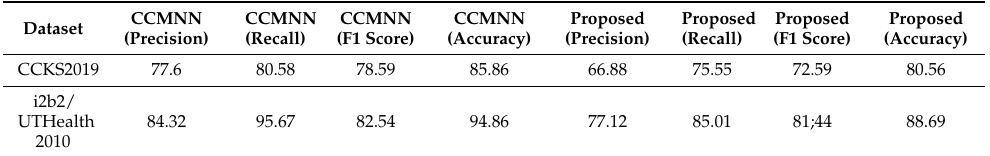
Table 5. Performance of the Proposed Method.